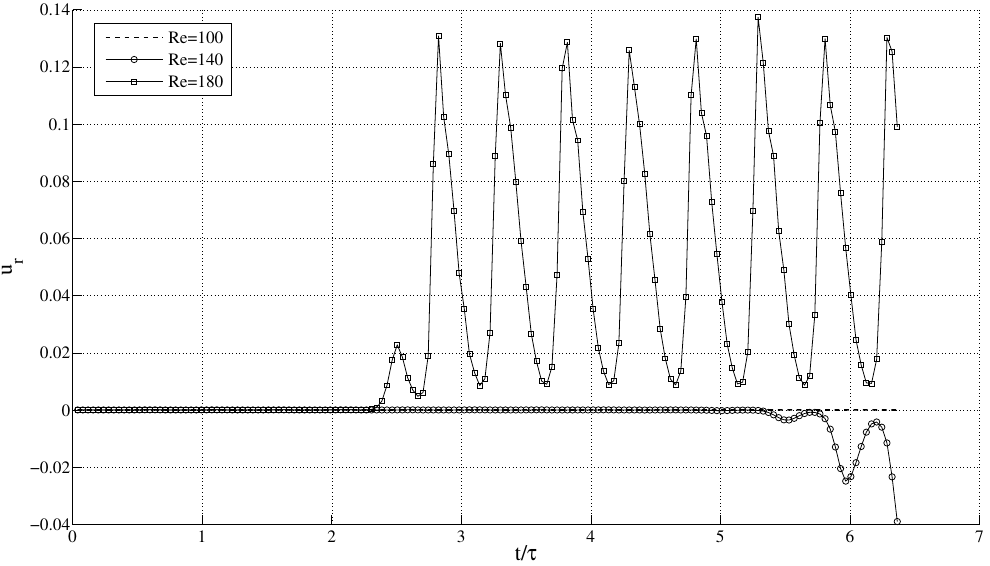
Figure 9. Variation of radial velocity with time for different Re for the varying angular speed case.